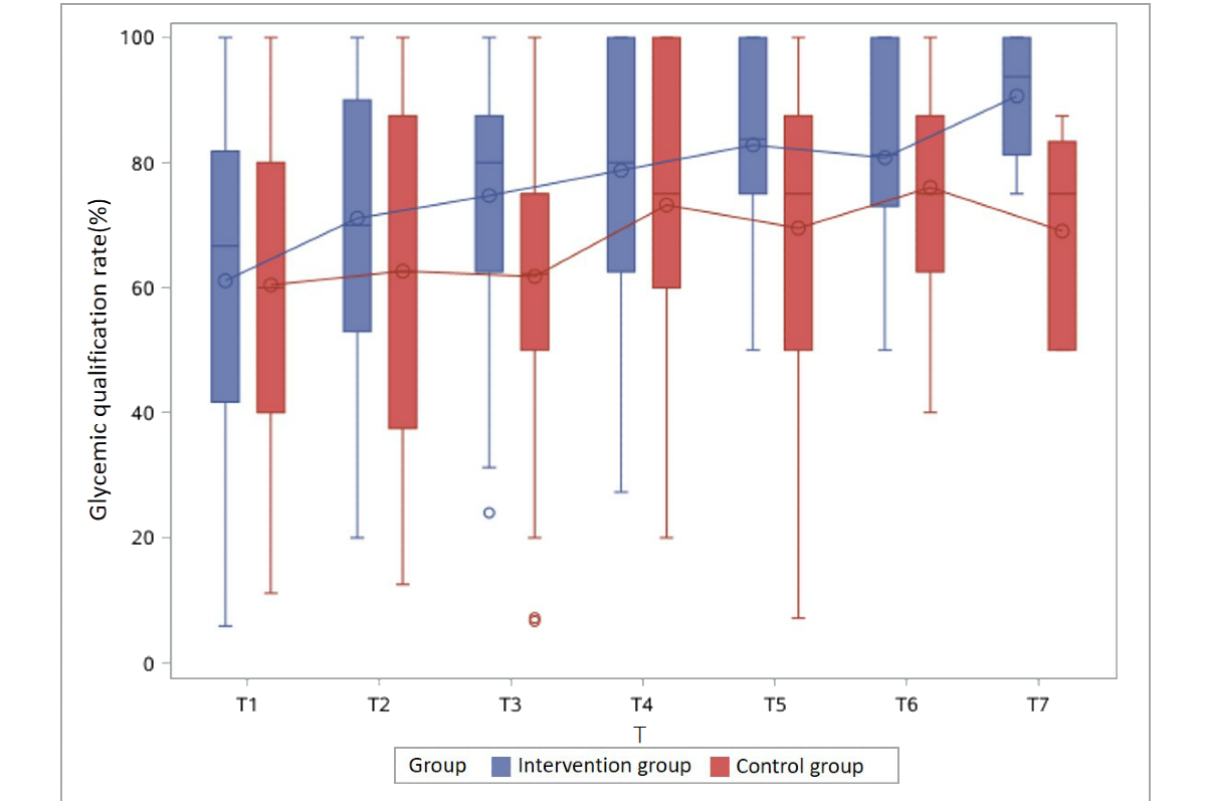
Figure 3. Glycemic qualification rate of the intervention and control groups in Group 2 (enrolled between 25 and 26 [+6] gestational weeks) at different time points. T: 2-week